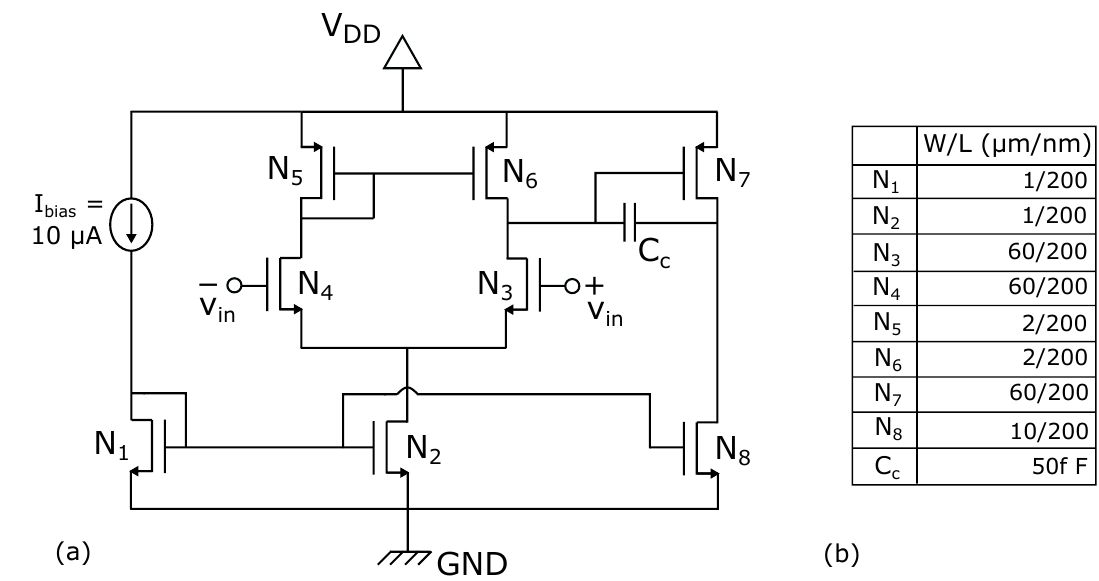
Figure 7. Two-stage Miller-compensated opamp of Figure 6, ( a ) schematic and ( b ) device sizes. Transient simulations were used to check the nonlinearity mitigation. Digital demod- ulation and sampling logic were modeled in VerilogA language. 10-fF capacitors were placed at the outputs of the ring-oscillator to simulate the input capacitance of the digital logic. Oscillation parameters were kept similar to Figure 3, except K VCO · g m , which was equal to 1.25 GHz/V, slightly higher than before due to linearity compensation. Figure 8 depicts the result of the nominal transient simulation. The HD3 and HD5 were equal to − 67 and − 75 dBc, respectively, leading to an SNDR of 63 dB (the HD2 value observed in a single-ended configuration was − 63 dBc). The distortion is substantially mitigated in comparison to Figure 3. The same simulation was performed with output capacitors of 30 and 50 fF, achieving SNDR values of 62.8 dB and 61.7 dB, respectively, due to the slight decrease in the oscillator gain. The proposed solution achieved a THD value of − 66.4 dBc for a differential input of 800 mV pp , [32] reported a THD chip measurement of − 63.6 dBc for a differential input of 566 mV pp , and [52] reported a THD of − 65.3 dBc for a differential input of 400 mV pp in simulation.